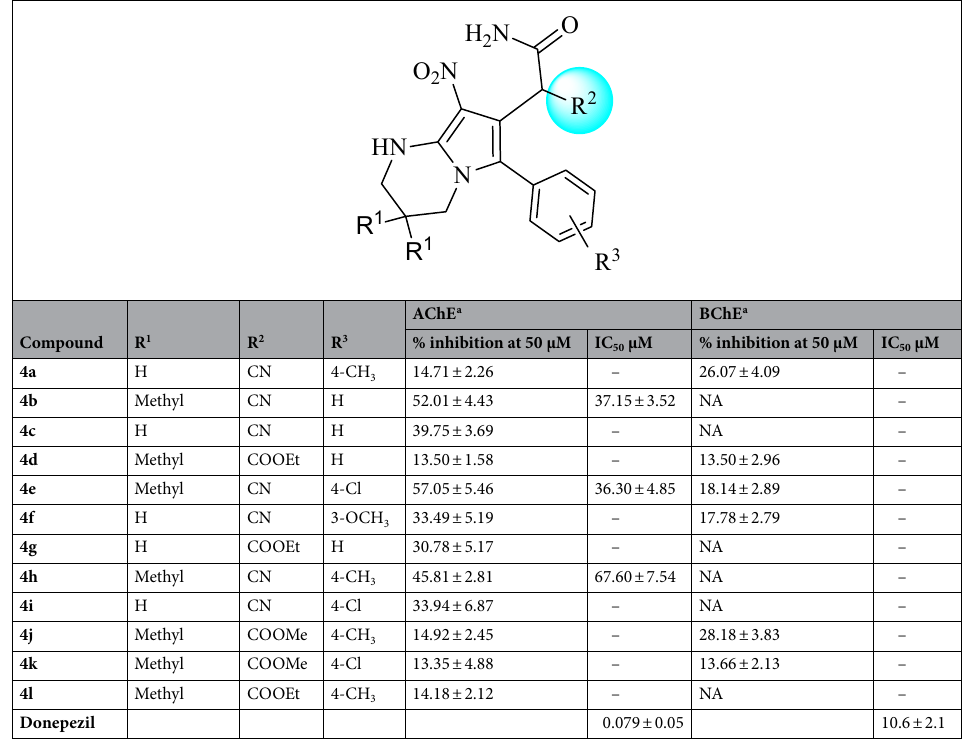
Table 2. IC 50 values and percent inhibitory activity of polysubstituted pyrroles against AChE and BChE enzymes. a Data represented in terms of mean ±